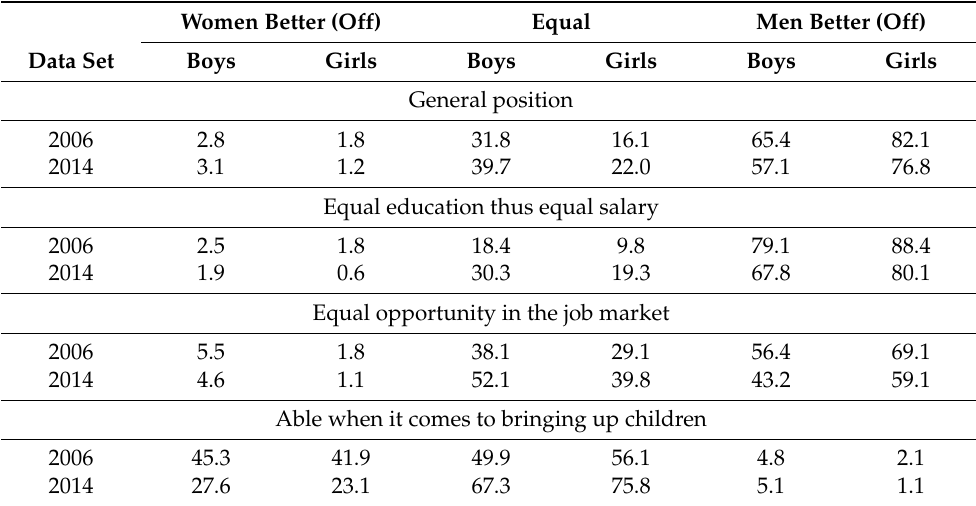
Table 3. Percentage attitude towards the position of men and women in Icelandic society on vari- ous aspects.